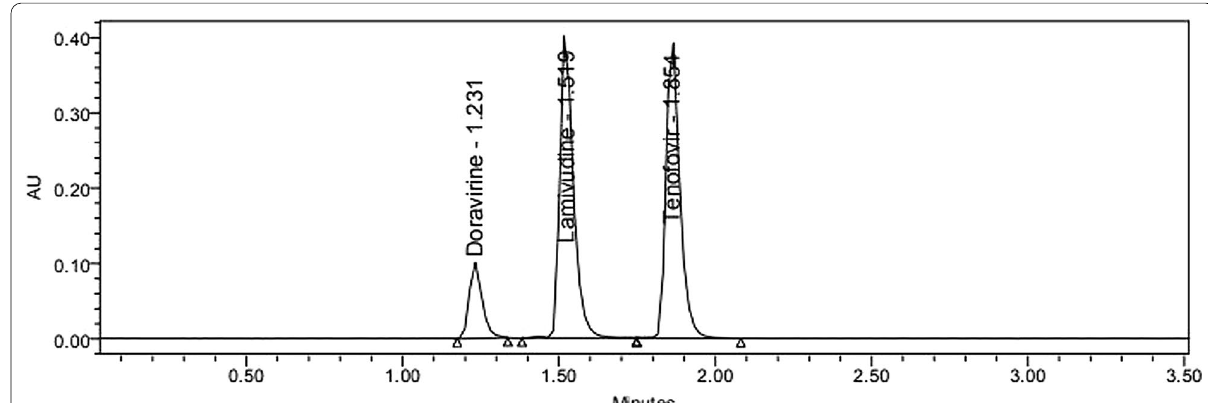
Fig. 4 Chromatogram of the neutral degradation